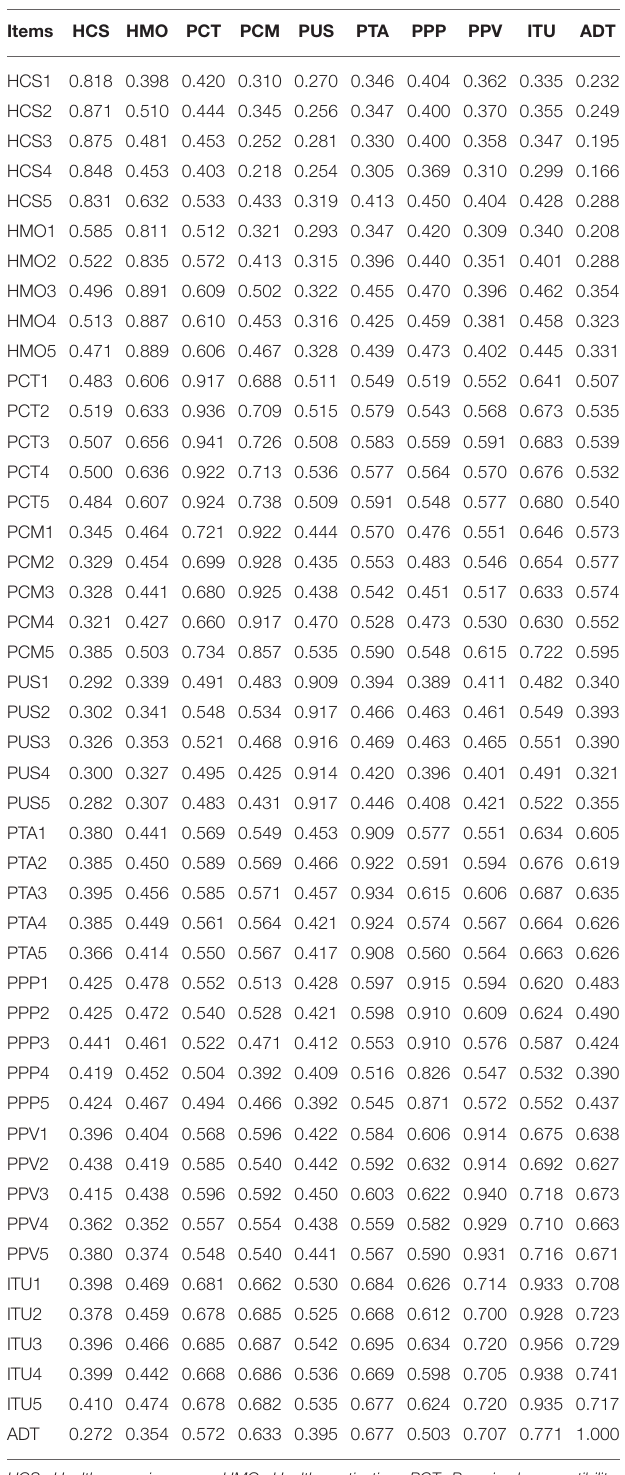
TABLE 4 | Loading and cross